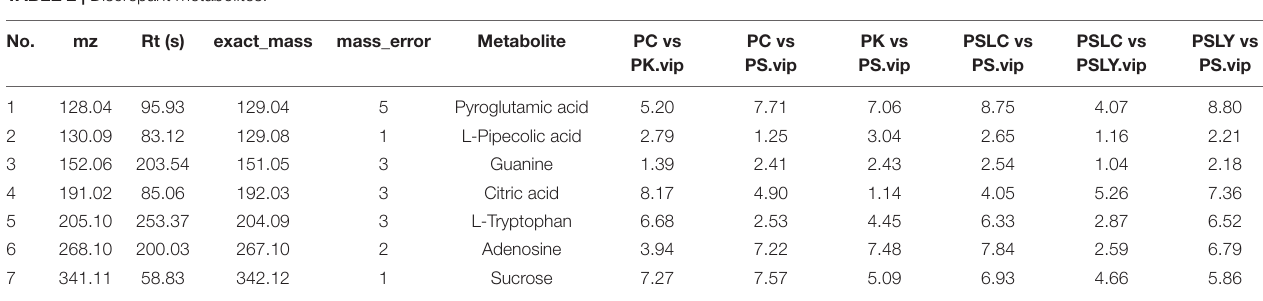
TABLE 2 | Discrepant